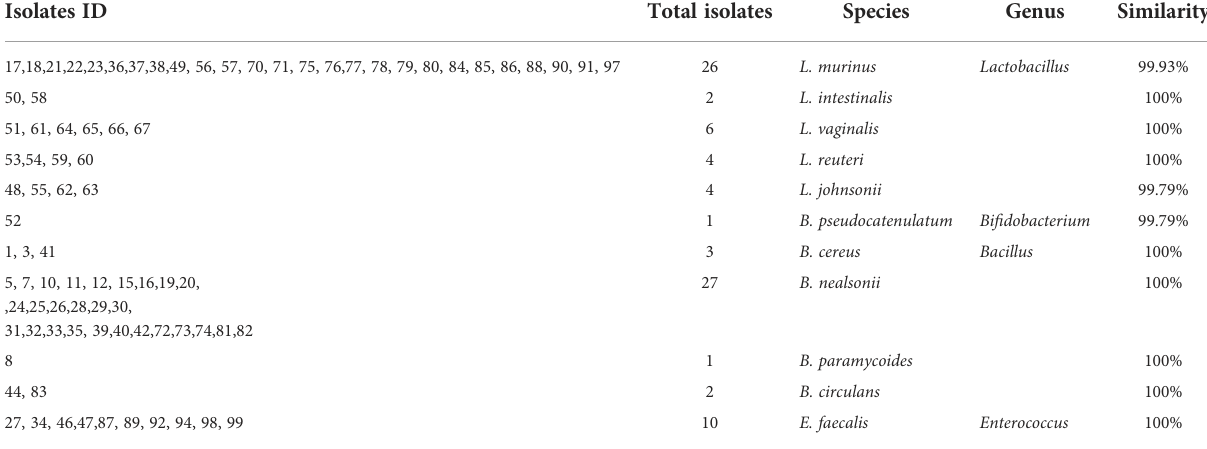
The 16S rRNA gene sequences of the isolates in Table 3 have been deposited in GenBank databases under the accession numbers